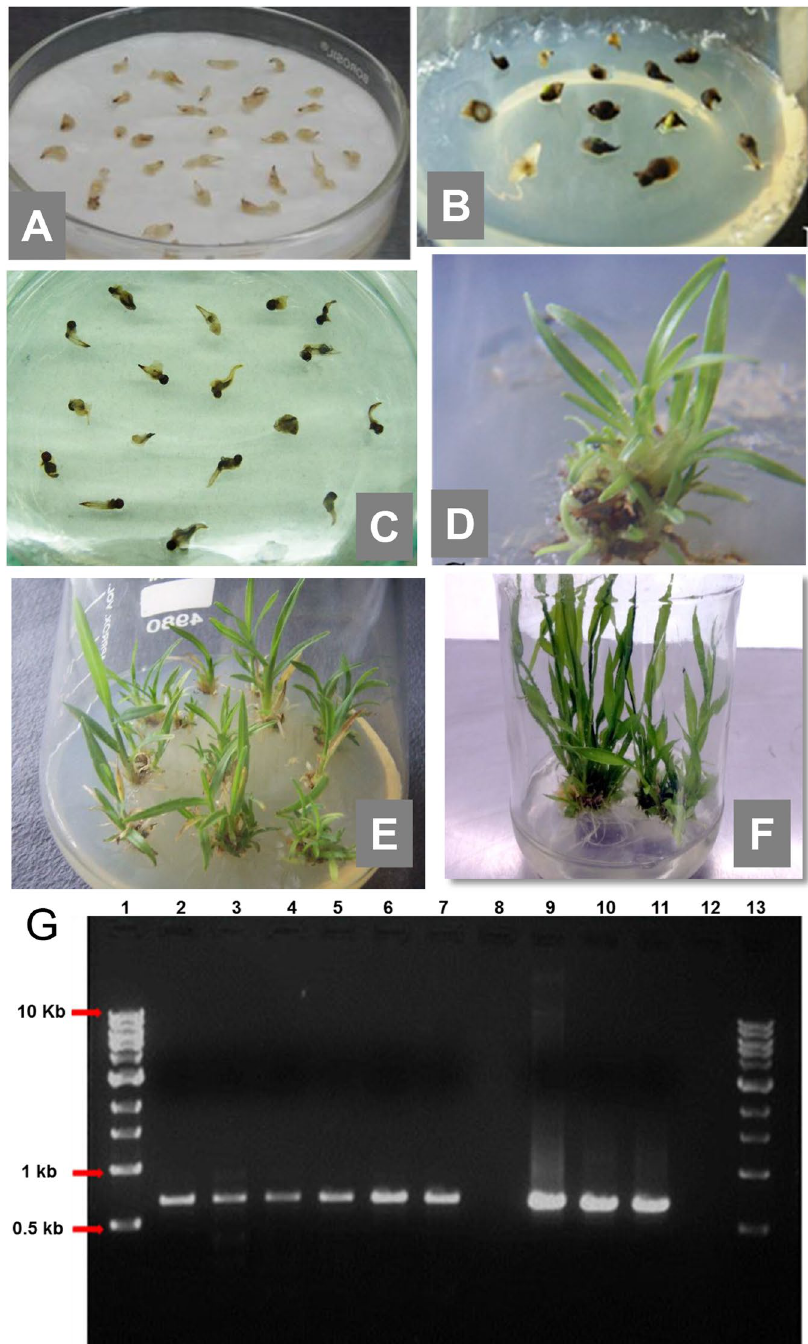
Figure 4. Agrobacterium -mediated transformation, regeneration using shoot apex explants and confirmation of transformation by PCR in foxtail millet genotype Maxima. Co-cultivation of shoot apex explants on sterile filter papers over MS medium containing 0.5 mg/L BAP and 100 µ M acetosyringone after 3 days on incubation in the dark ( A ), selection of co-cultivated explants on the shoot induction (SIM) medium containing MS salts, 0.5 mg/L BAP, 25 mg/l hygromycin and 250 mg/l cefotaxime, after 2 weeks of incubation in the light ( B ). The production of hygromycin resistant shoots are visible ( B ), un-transformed (negative control) explants in the same SIM are dead after 2 weeks of incubation ( C ), production of hygromycin resistant shoots in the SIM with MS salts, 0.5 mg/L BAP, 25 mg/l hygromycin and 250 mg/l cefotaxime, after 4 weeks of incubation ( D ), elongation of shoots in the shoot elongation medium (SEM) medium containing MS salts, 25 mg/l hygromycin and 250 mg/l cefotaxime, after one week of incubation in the light ( E ), rooting of shoots in the same medium after 3 weeks of incubation in the light ( F ). Confirmation of transformation by detection of hptII gene in primary transformants (T0) by PCR ( H ). Lane 1 and 13 = 1 kb DNA ladder. Lane 2 and 3 = SiPHT1 ; 2 RNAi lines. Lanes 4 and 5 = SiPHT1 ; 3 RNAi lines. Lanes 6 and 7 = SiPHT1 ; 4 RNAi lines. Lane 8 = negative control (genomic DNA of non-transformed plant). Lane 9 = pFGC- SiPHT1 ; 2-RNAi plasmid (positive control). Lane 10 = pFGC -SiPHT1 ; 3-RNAi plasmid (positive control). Lane 11 = pFGC- SiPHT1 ; 4-RNAi plasmid (positive control). Lane 12 = Water control (no template